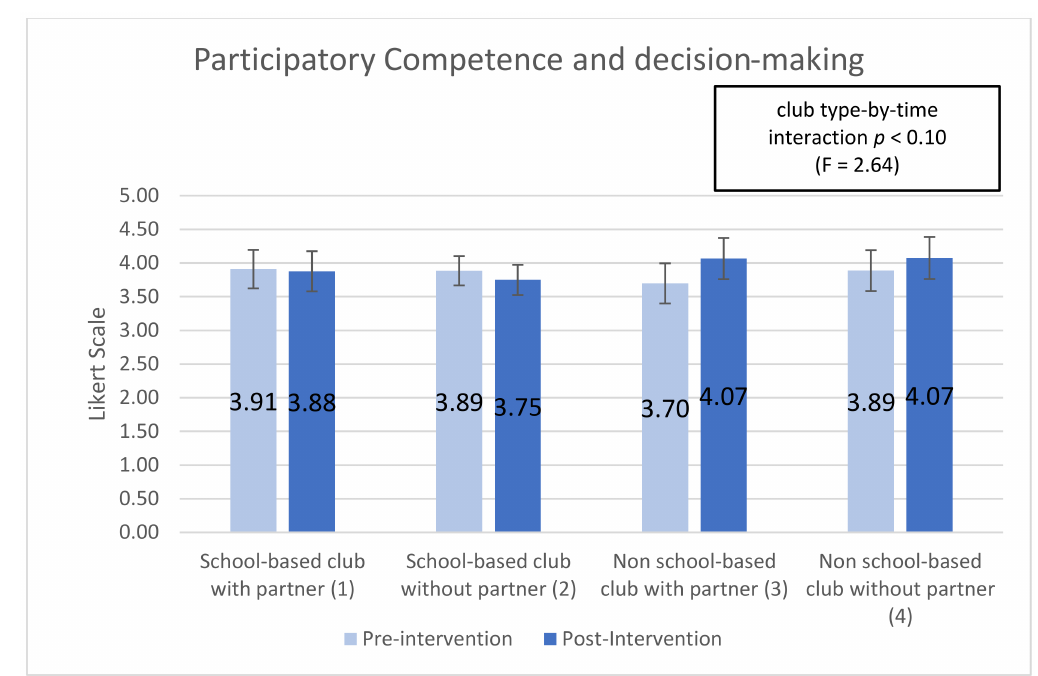
Figure 3. Participatory Competence and decision-making pre- post-assessments by club type and partnership.